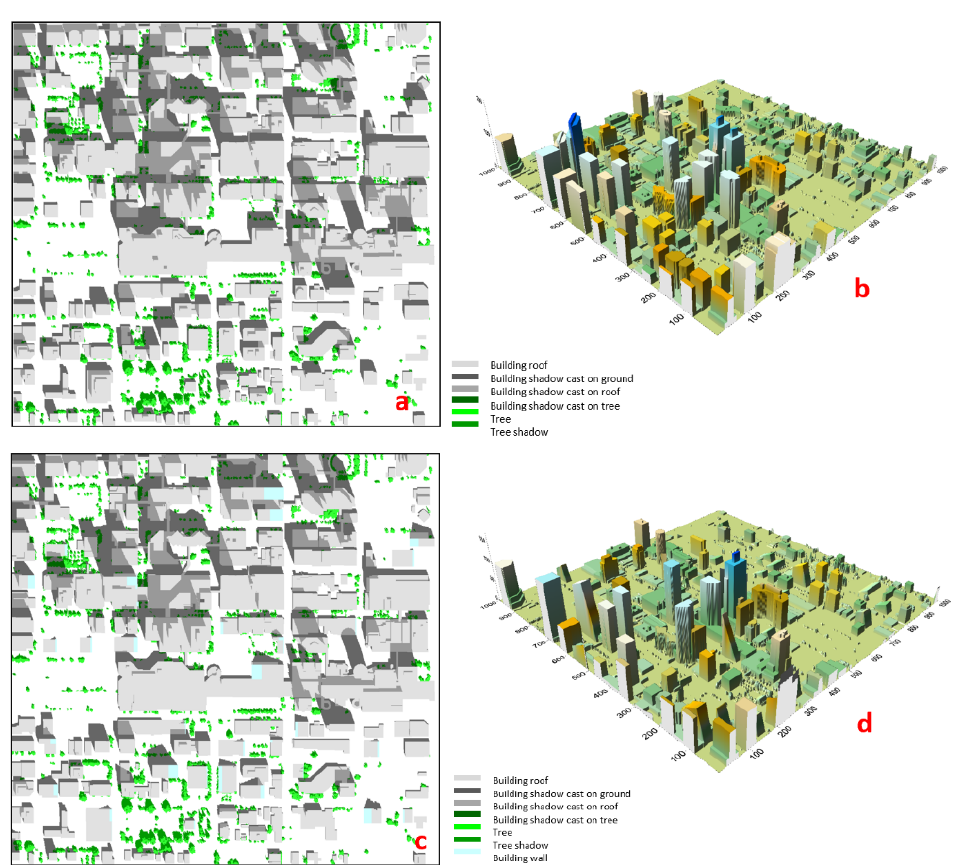
Figure 13. The baseline ( a ) and simulated ( c ) shadow maps, the baseline ( b ) and simulated post-damage ( d ) DSMs. The building damage simulated includes the building damage models listed in Table 1. The total building damage area is 85%.